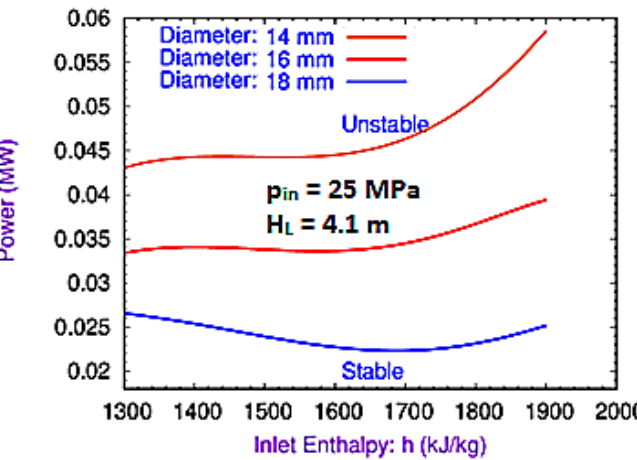
Figure 6. Effect of diameter on the DWI of the loop [37].